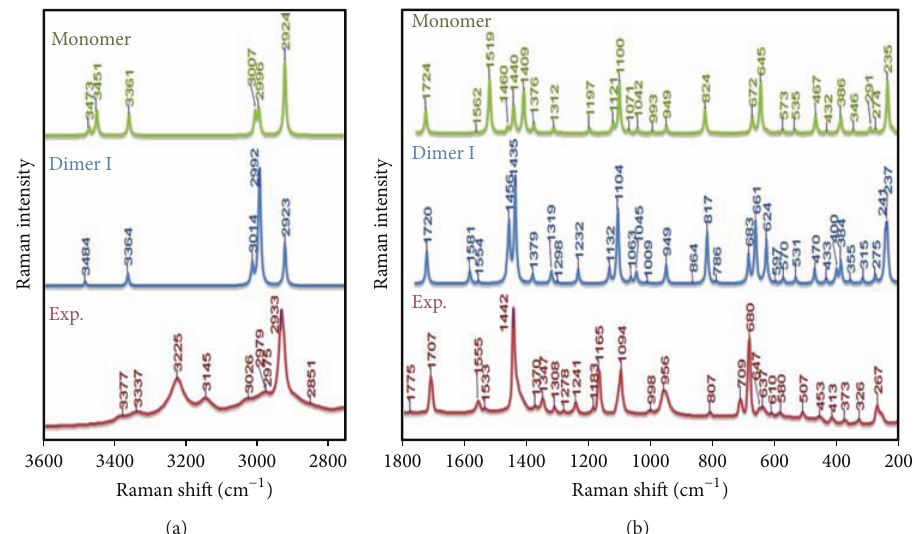
Figure 6: Experimental (solid) and calculated (scaled) Raman intensities spectra of acetazolamide in the regions 3600–2800 cm −1 (a) and 1800–200 cm −1 (b),